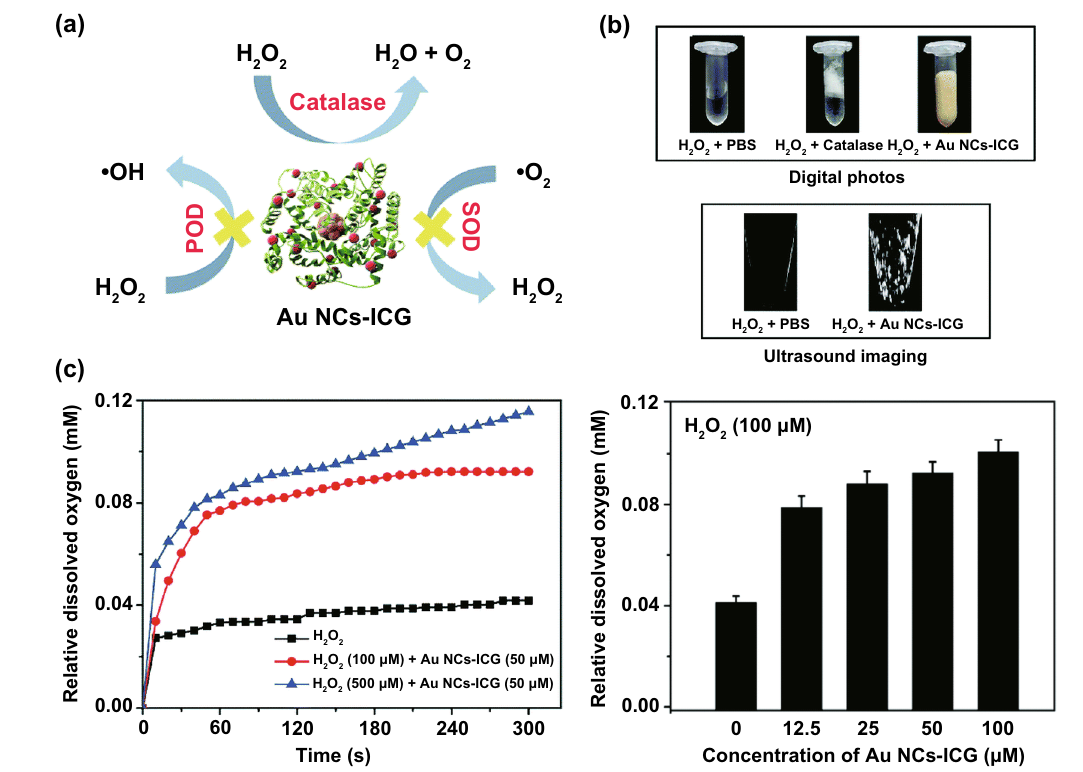
Fig. 5 a Schematic illustration for Au NCs-ICG with high CAT-like activity. b Bright and ultrasound images of H 2 O 2 after different treatments. c O 2 production ability of Au NCs-ICG in the presence of H 2 O 2 . Reproduced with permission from Ref. [86]. Copyright 2020, The Royal Soci- ety of Chemistry